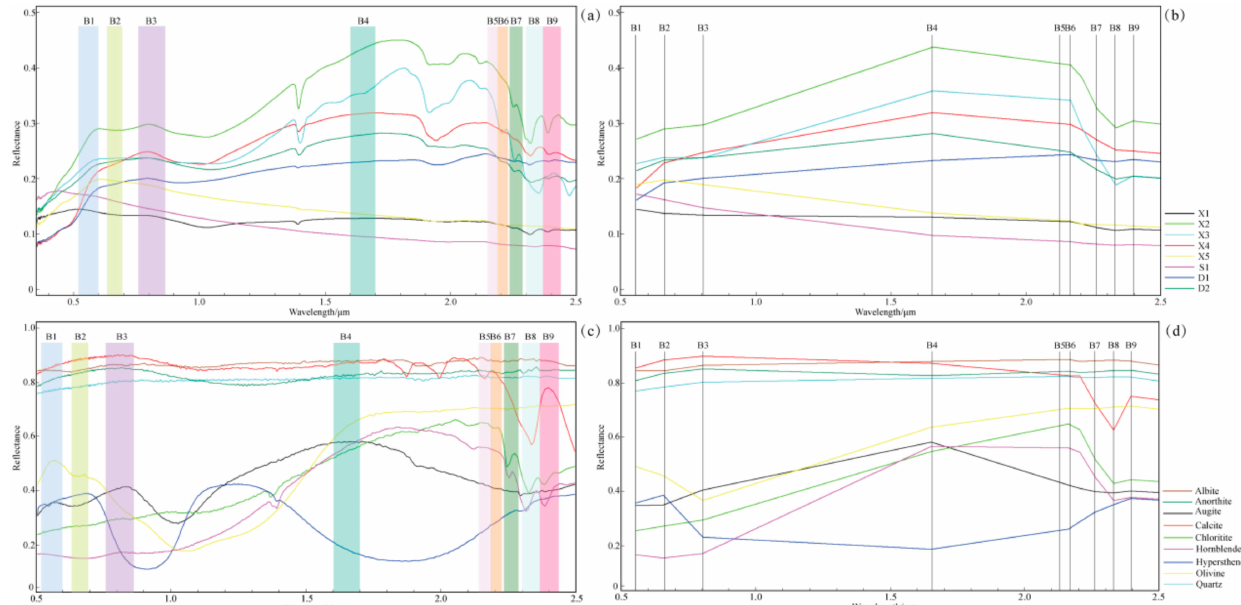
Figure 3. Reflectance curves of typical samples collected from Huangshan intrusions ( a ) and the spectra curves resampled to the advanced spaceborne thermal emission and reflection radiometer (ASTER) visible and near-infrared (VNIR)- shortwave infrared (SWIR) bands ( b ). Reflectance curves of related minerals from United States Geological Survey (USGS) mineral spectral library ( c ) and the spectra curves resampled to the ASTER VNIR-SWIR bands ( d ). Location of the samples is shown in Figure